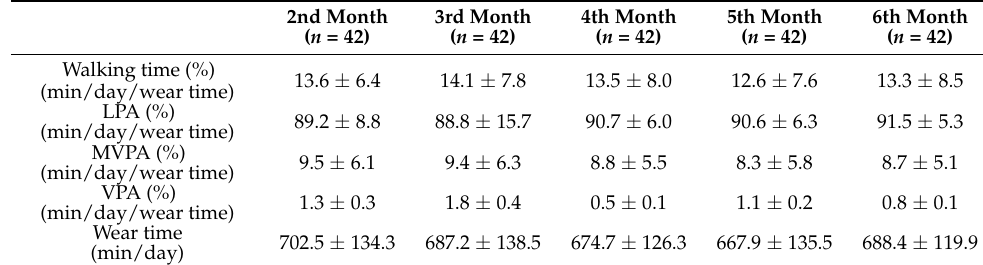
Table 5. Physical activity during the intervention